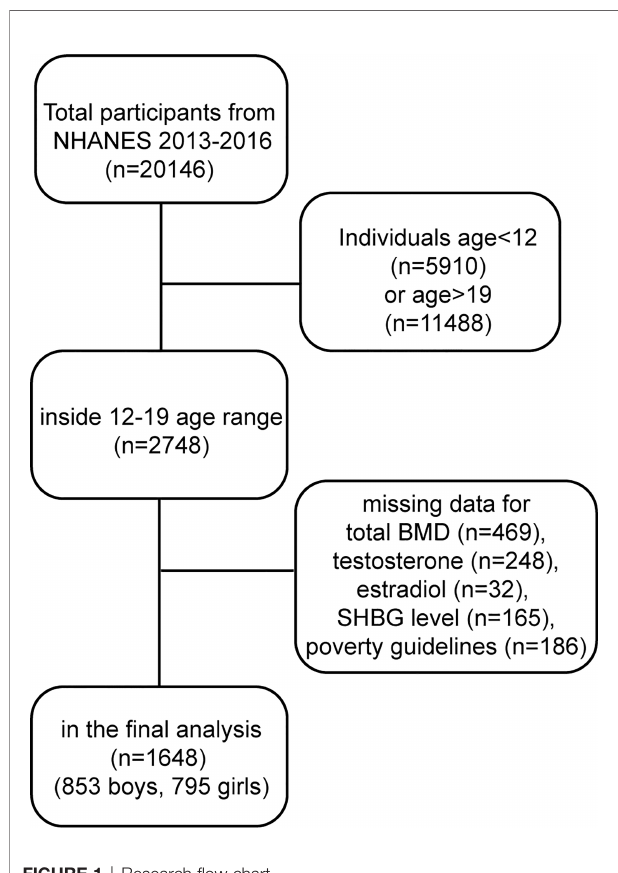
FIGURE 1 | Research fl ow